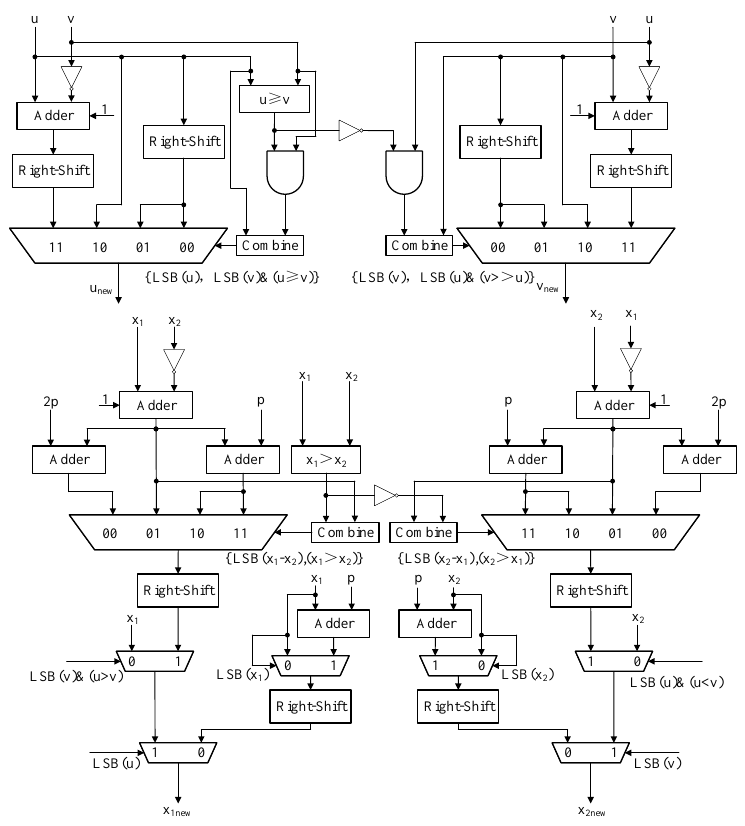
Figure 2. Architecture of proposed modular